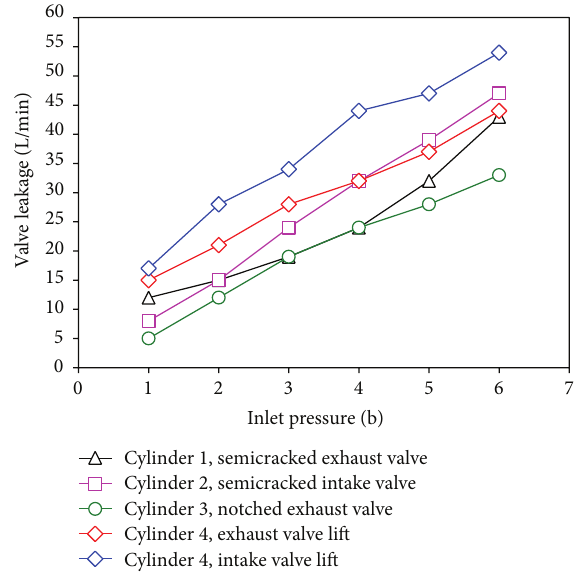
Figure 5: VL rate of all cylinders versus inlet pressurized